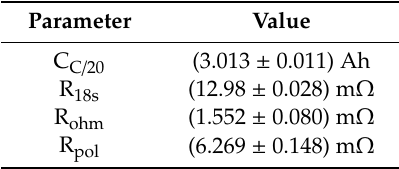
Table 1. Averaged cell parameters and their deviation at begin of life.